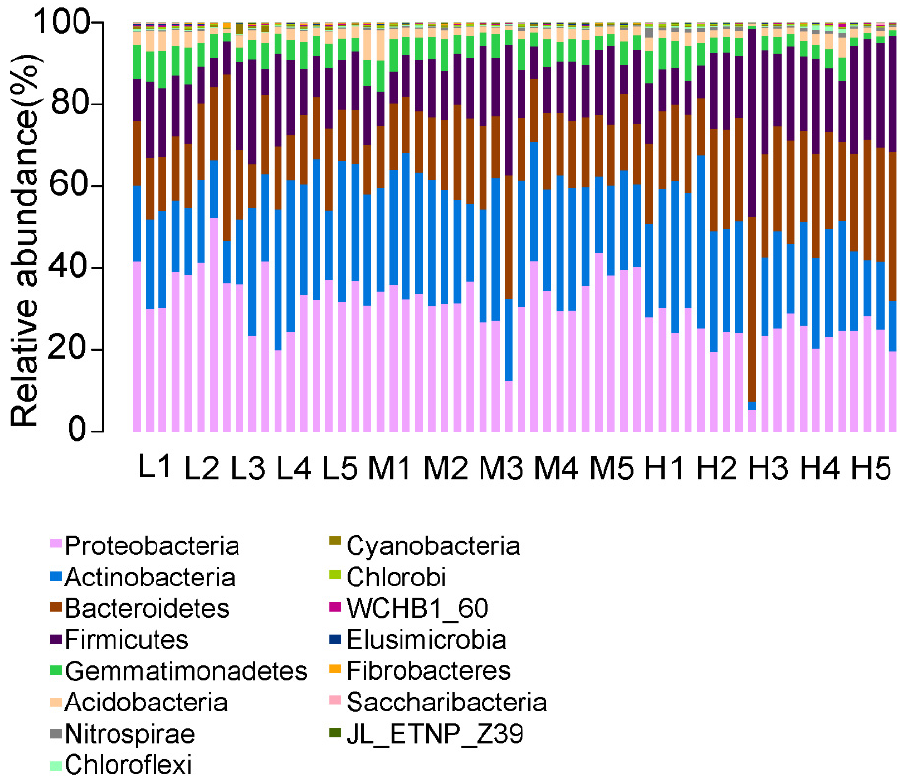
Figure 7. Chart of the relative abundance of the different levels of bacteria at the phylum level in the 0–20 cm depths soil at 5, 20, 50, 100, and 400 m from the curb G109 highways at altitudes of 4000 m, 4600 m, and 5200